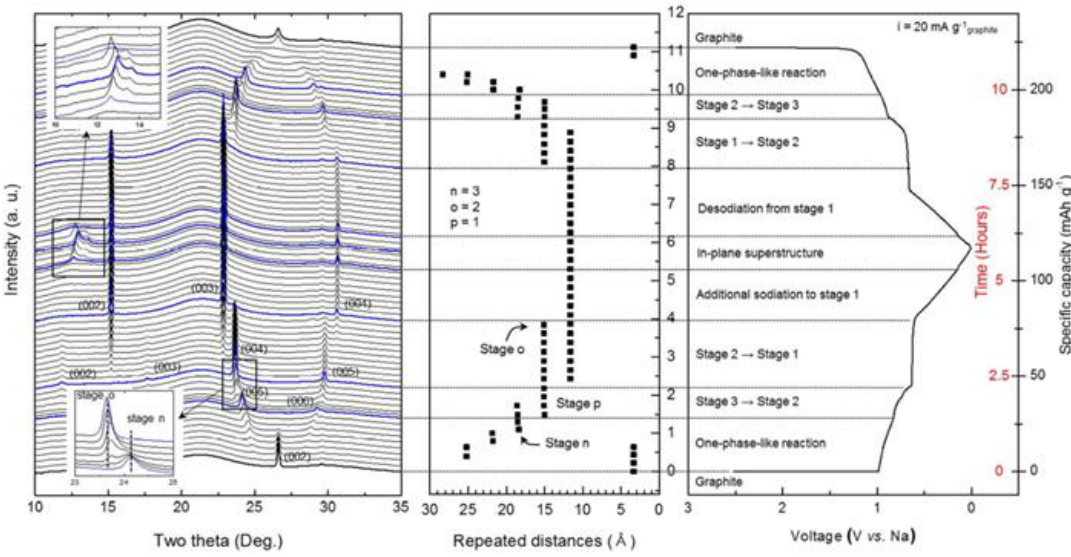
Figure 12. Operando synchrotron X-ray diffraction analysis of the structural evolution of the ternary Na-ether-graphite system observed during electrochemical solvated-Na-ion intercalation and de- intercalation of graphite in Na | 1 M NaPF 6 in a DEGDME | graphite cell [95]; with permission from RSC